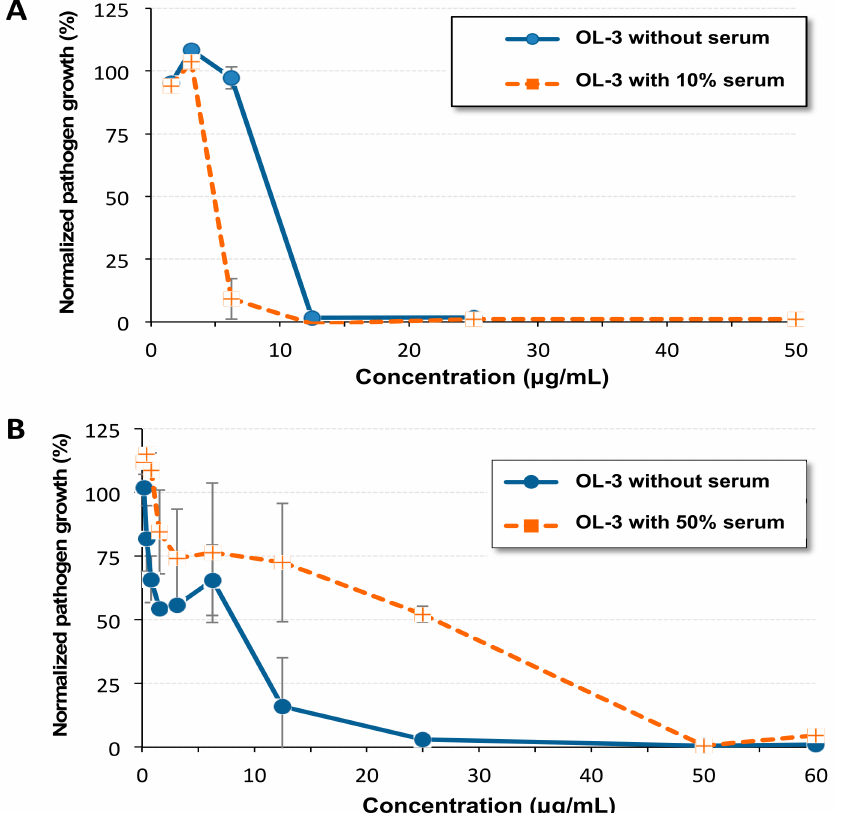
Figure 4. Evaluation of the minimal inhibitory concentration (MIC) of OL-3 towards MRSA . Con- centrations are expressed in µ g/mL. OL-3 was incubated for 24 h at 37 ◦ C in 100 µ L MHB medium supplemented or not with 10% fetal bovine serum ( A ) or 50% of nondecomplemented fetal calf serum ( B ) with MRSA. Each value corresponds to the mean value of three samples and error bars correspond to standard deviation.